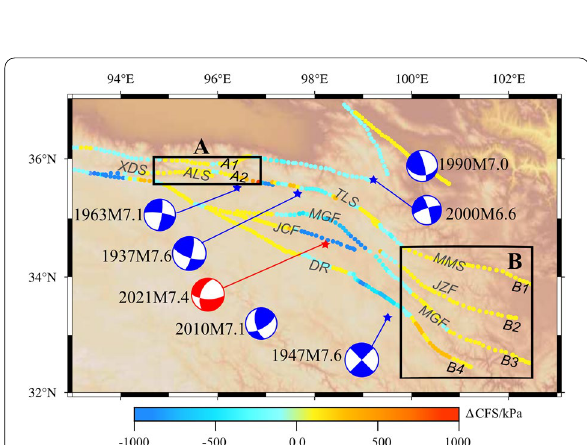
Fig. 7 The combined ΔCFS on major faults caused by 14 historical events and 2021